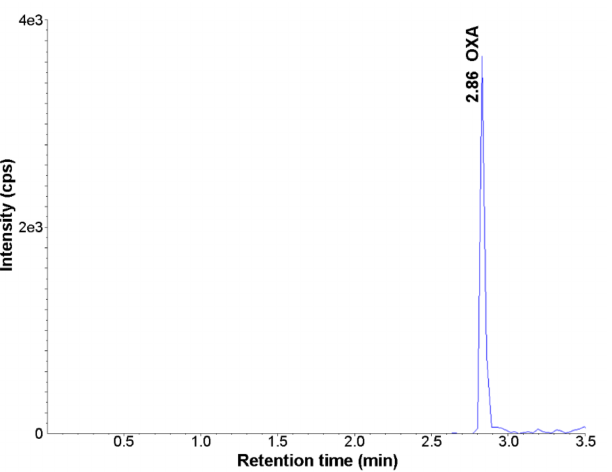
Figure 3. Representative MRM chromatogram of orexin A in the rat vitreous body sample (MRM1; m / z 713.3 → 858.6) (UHPLC-MS/MS method).